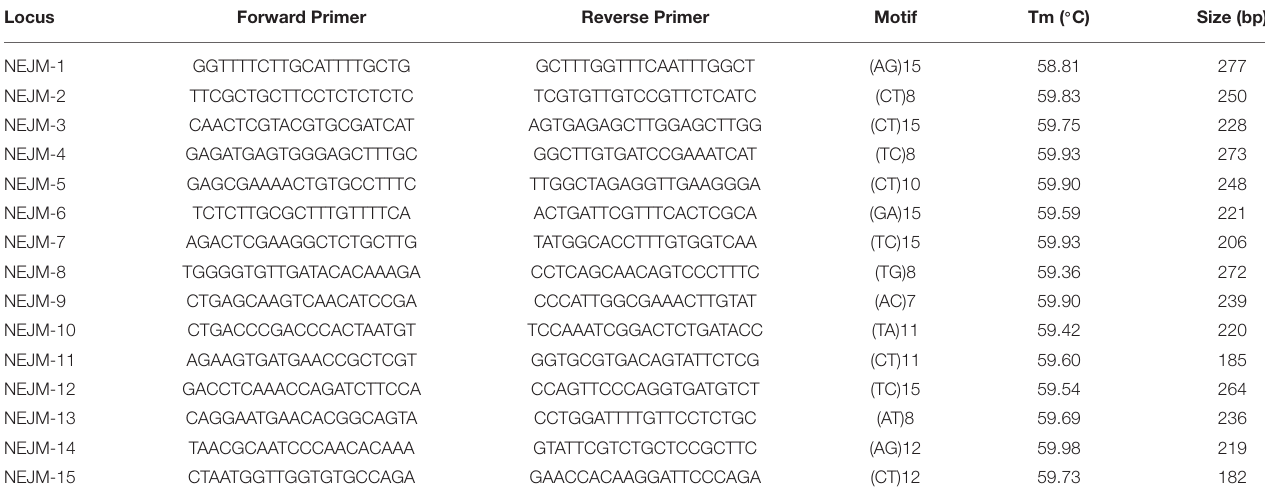
TABLE 2 | EST-SSR primer information of J. mandshurica .